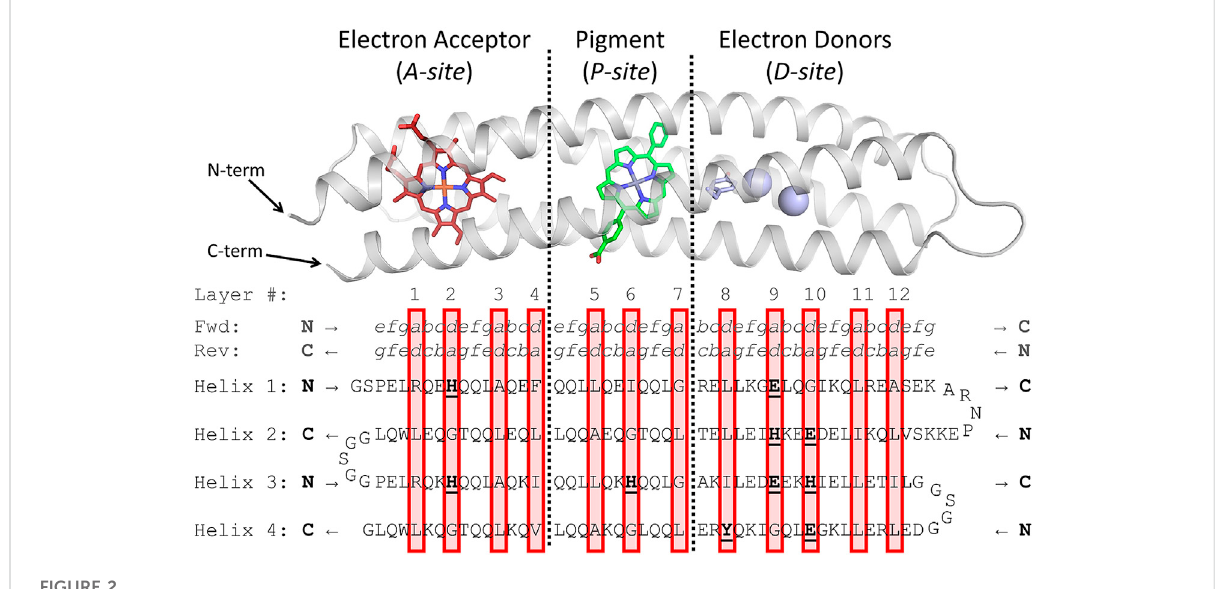
FIGURE 2 DesignofRCmaquetteaminoacidsequence.Above,holo-statemodelofRCmaquettedesignisshownwithelectronacceptorinred,pigment in green, and electron donors in light blue. Below, amino acid sequence of RC maquette is written with each helix on a new line. Helices 2 and 4 are written backwards from C to N-terminus (bold black letters at ends of each helix indicate N- or C-terminus of that helix). (Full forward sequence is given in Supplementary Table S1). Amino acids in bold and underlined are directly involved in cofactor assembly. Heptad positions a through g aregivenabovetheproteinsequenceforforwardandreversedirections.Redboxesencloselayersofthehydrophobiccore(numberedabove).Each layer includes two a - and two d -position